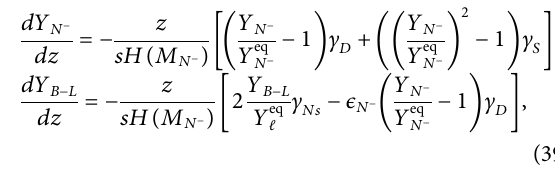
where N f represents the number of fermion generations and N H denotes the number of Higgs doublets. The observed baryon